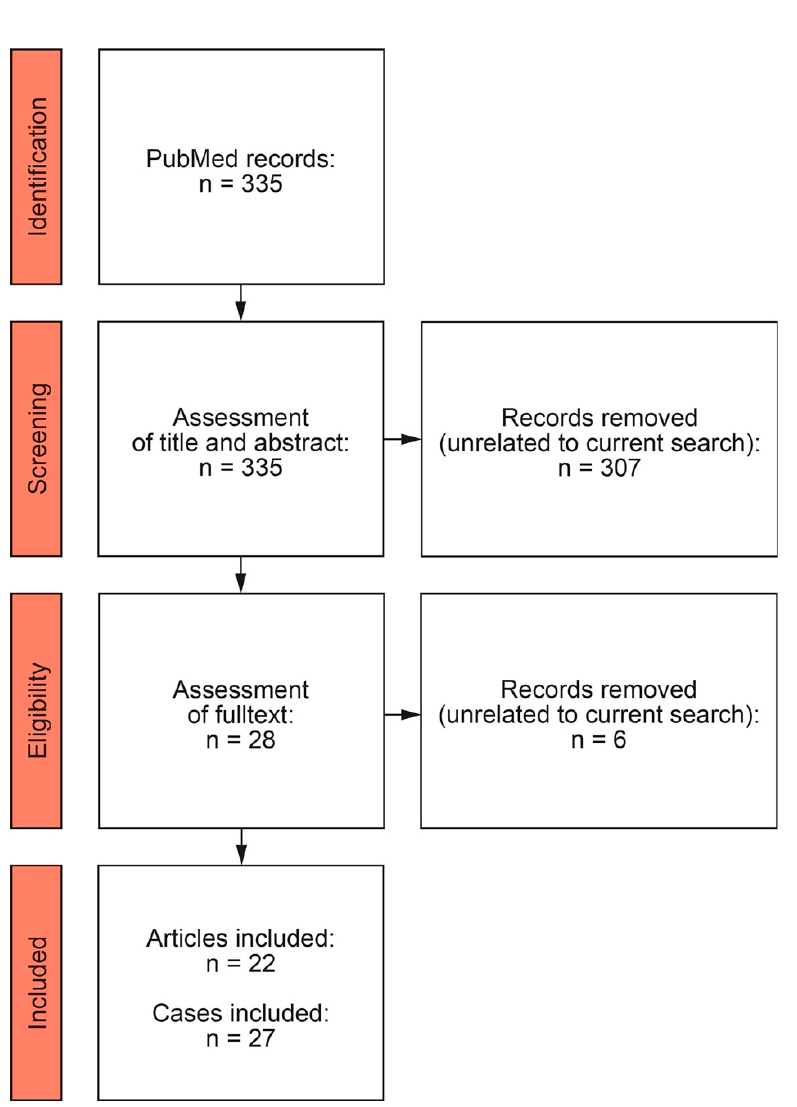
Figure 2. PRISMA flow diagram of the systematic review of the literature.